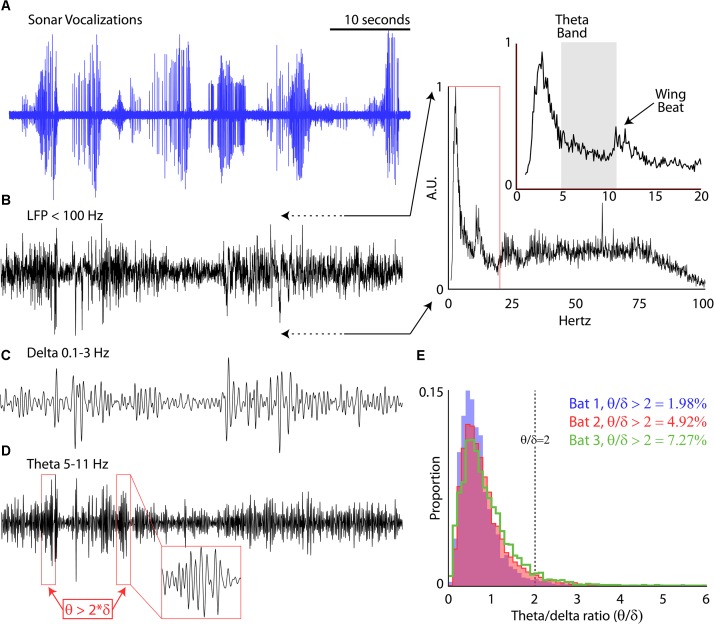
Prevalence of theta rhythm. (A) Sonar vocalizations from six consecutive trials of Bat 3 navigating the experimental flight room. (B) Local field potential (LFP, <100 Hz) recorded in the hippocampus during the six flights shown in (A). Inset, power relationship across frequencies ranging from 1 to 100 Hz (and 1–20 Hz in expanded portion, y-axis shown at same scale). (C) Band-pass delta rhythm of the LFP (0.1–3 Hz) during the six flights shown in (A). (D) Band-pass theta rhythm of the LFP (5–11 Hz) during the six flights shown in (A). Red boxes identify bouts of increased theta, defined as amplitudes greater than two times the amplitude of the delta band. Inset, zoomed few of one theta bout. (E) Proportion 1 s bins where theta bouts occurred for each bat during all experimental sessions (Bat 1, in blue, 11 sessions; Bat 2, in red, 11 sessions; Bat 3, in green, 16 sessions).